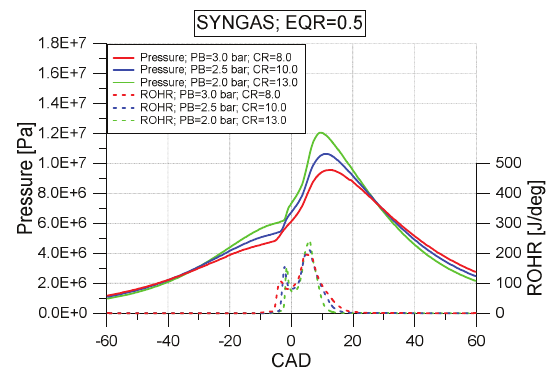
Fig. 9. Pressure trace and ROHR for syngas and MPI